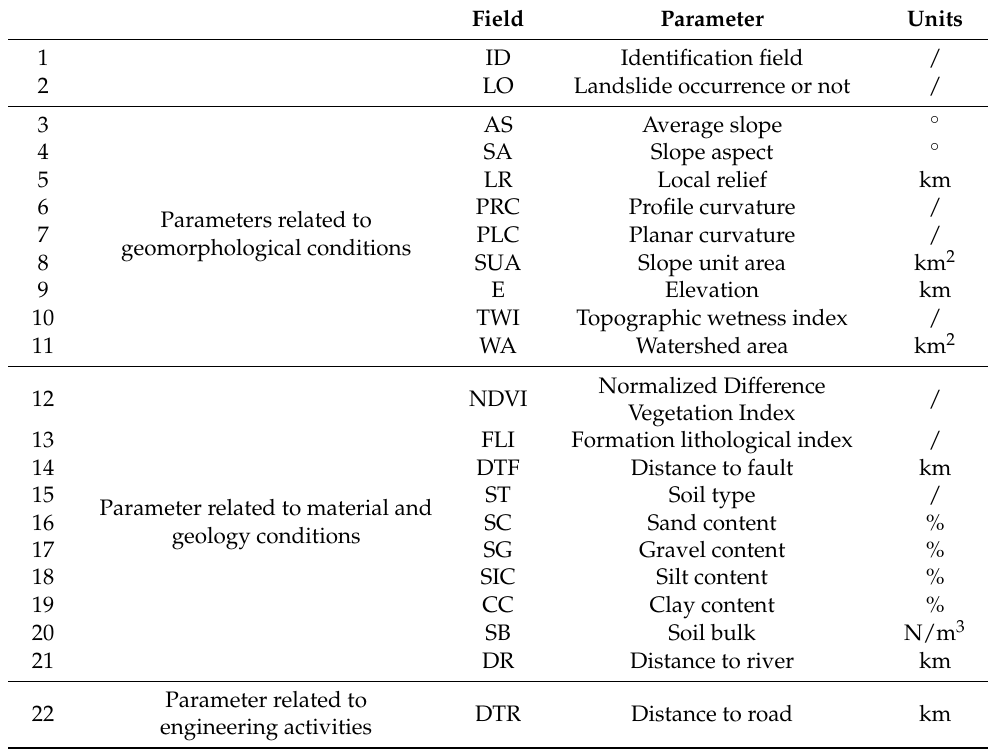
Table 1. Fields and characteristics of the spatial